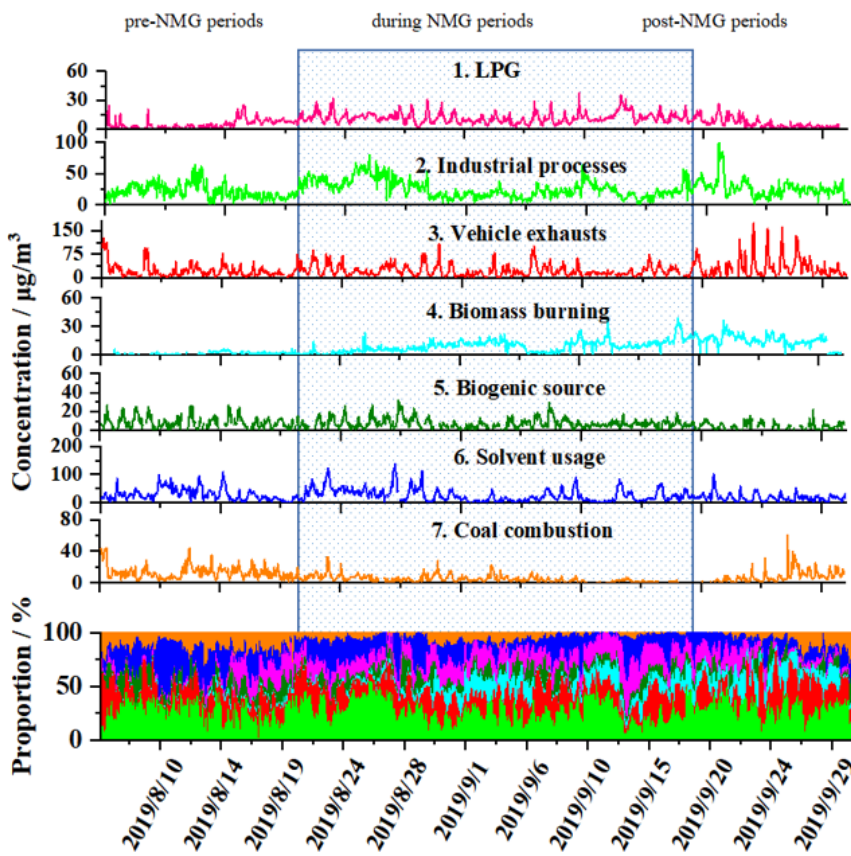
Figure 5. Time series of each identified source contributions and accumulated relative VOC contributions.